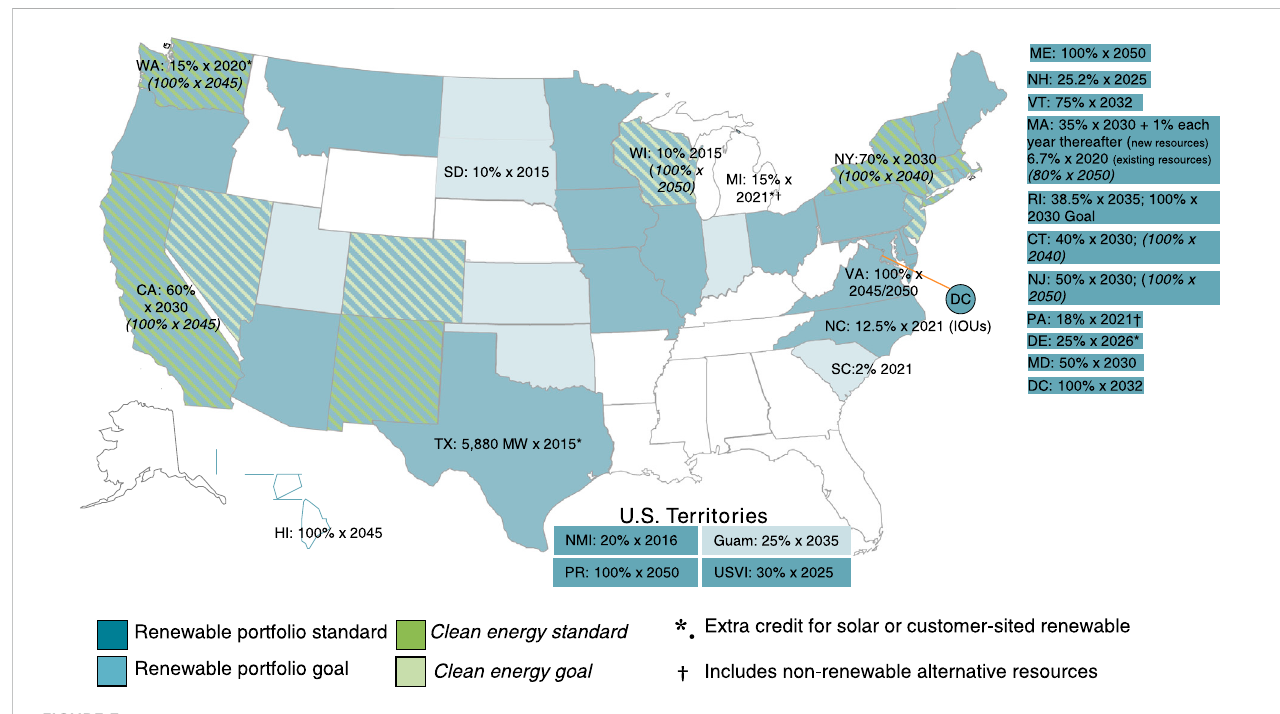
FIGURE 3 Figure 3: Summary map of Renewable and Clean Energy Standards in the USA. Source: Database of State Incentives for Renewable & Ef fi ciency (www. dsireusa.org/ September 2020)